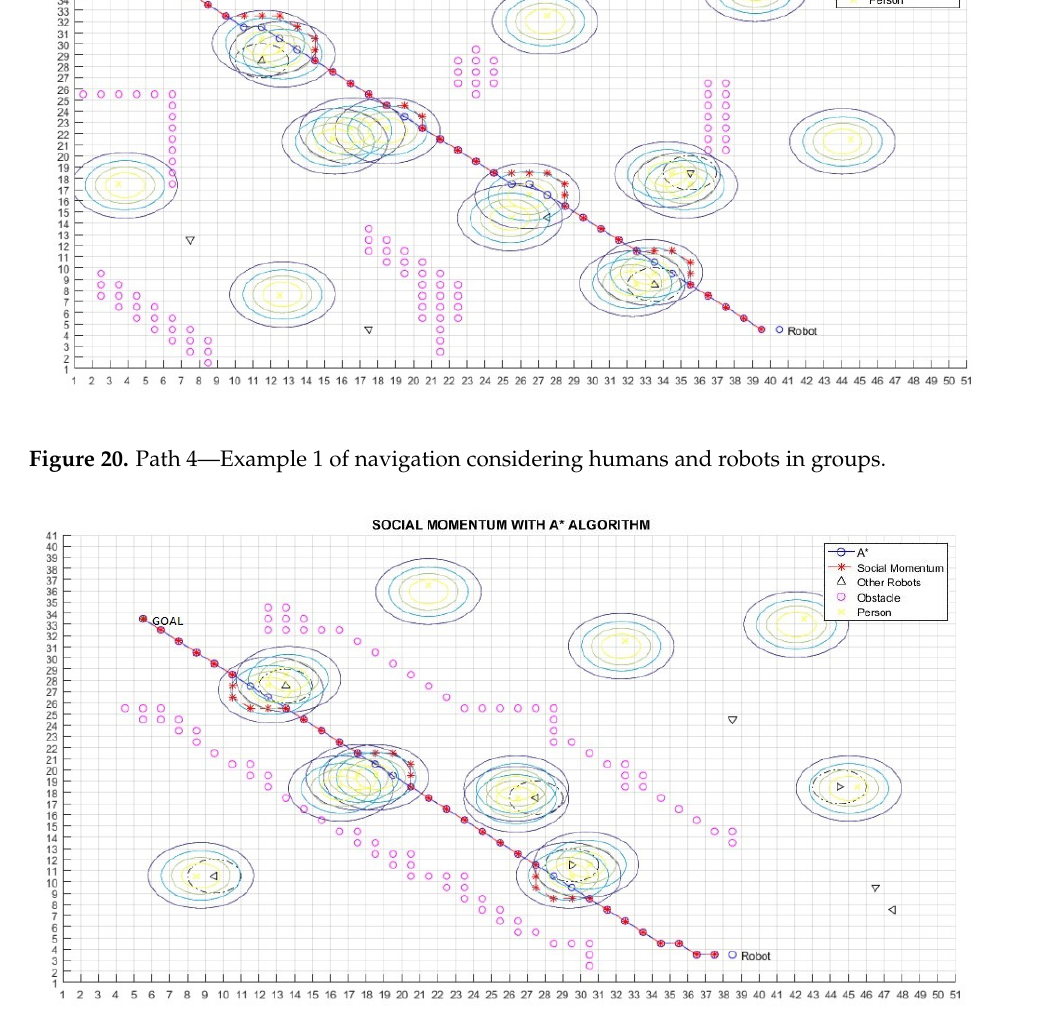
Figure 21. Path 5—Example 2 of navigation considering humans and robots in